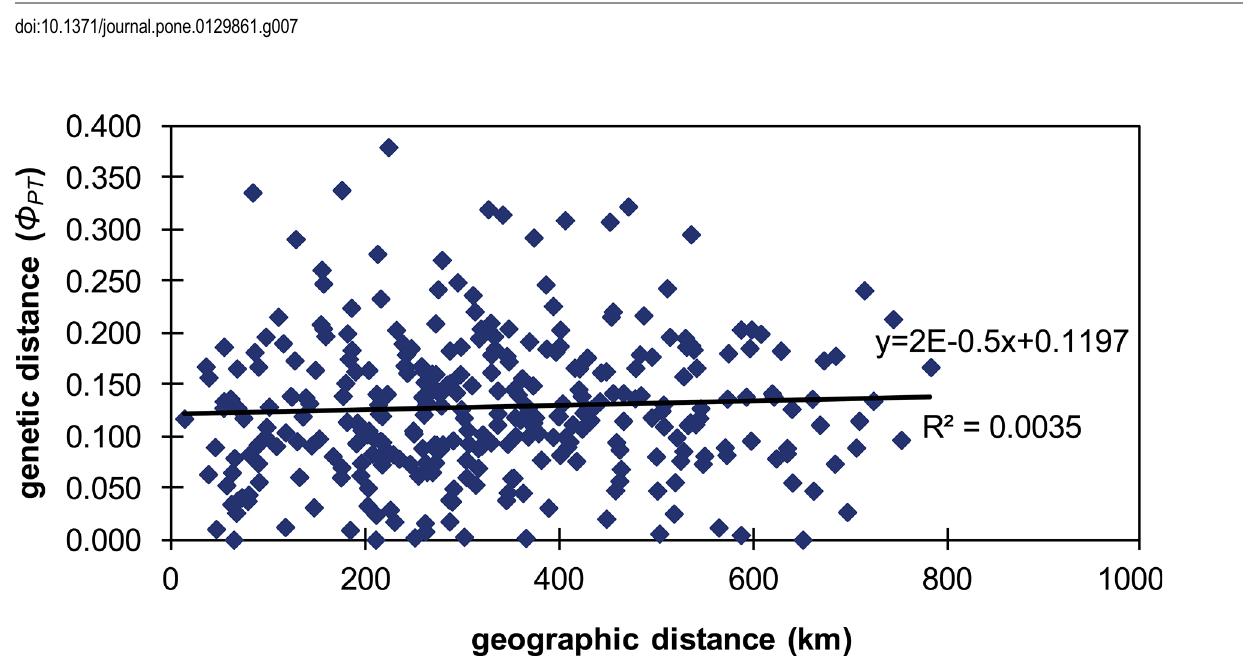
Fig 8. Mantel test correlating geographic distance and genetic distance. Results of the IBD test searching for a correlation between geographic distance and genetic distance.